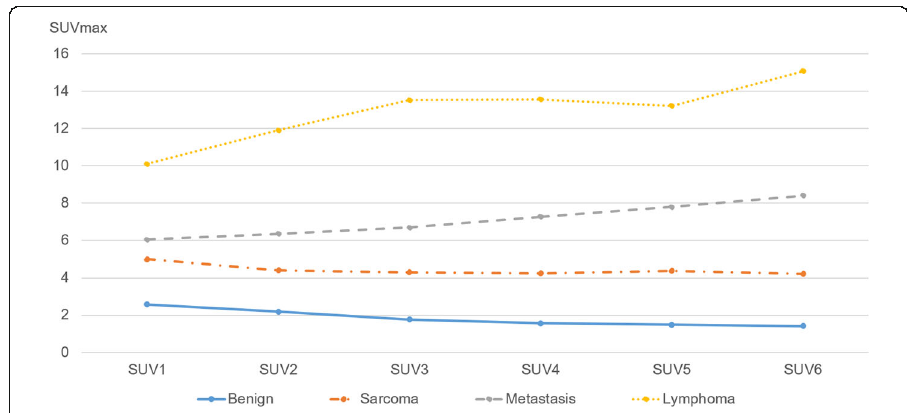
Fig. 1 The change in median SUVmax values for each time phase in benign and malignant musculoskeletal